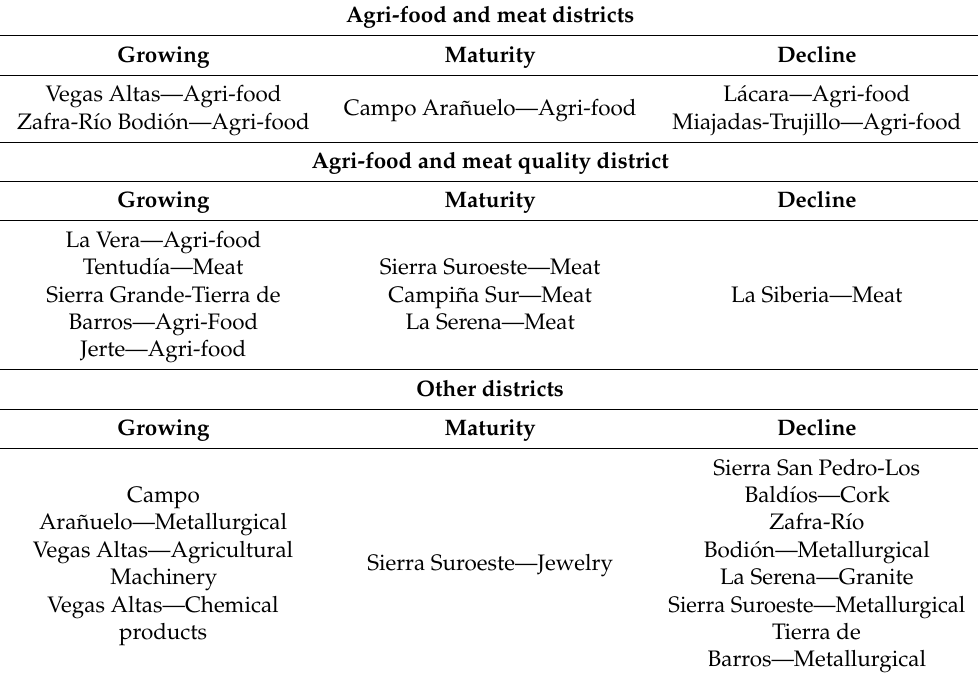
Table 6. Life cycle of Extremaduran rural